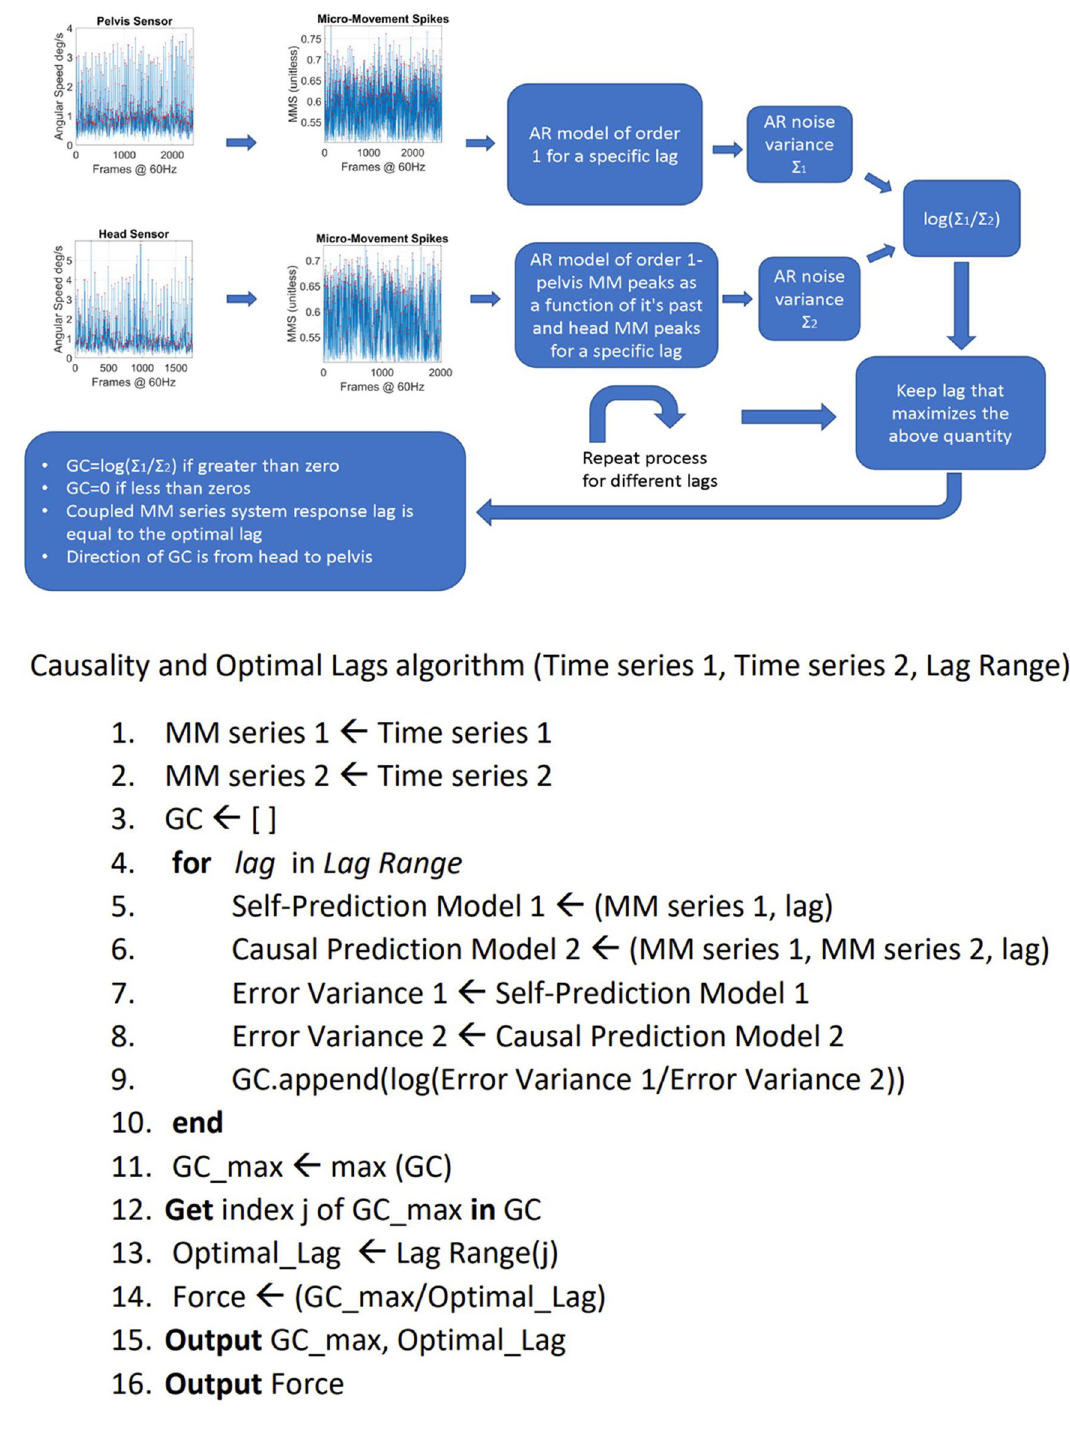
Figure 15. Pipeline for the estimation of the Granger Causality, Response time values and Force between two body